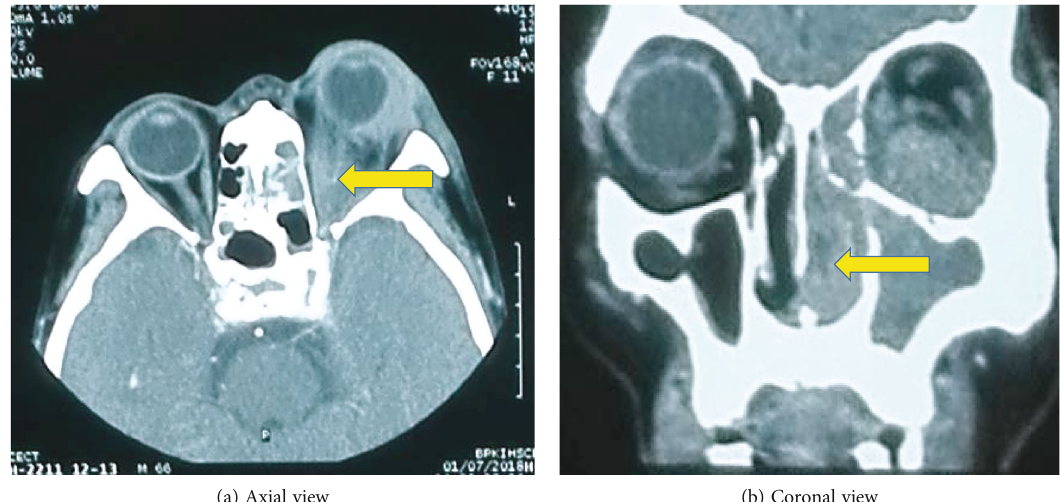
Figure 5: CECT-orbit: contrast enhanced intraorbital mass involving the optic nerve (as shown by an arrow in (a)) and the mass extending to sinonasal cavity (as shown by an arrow in (b)).